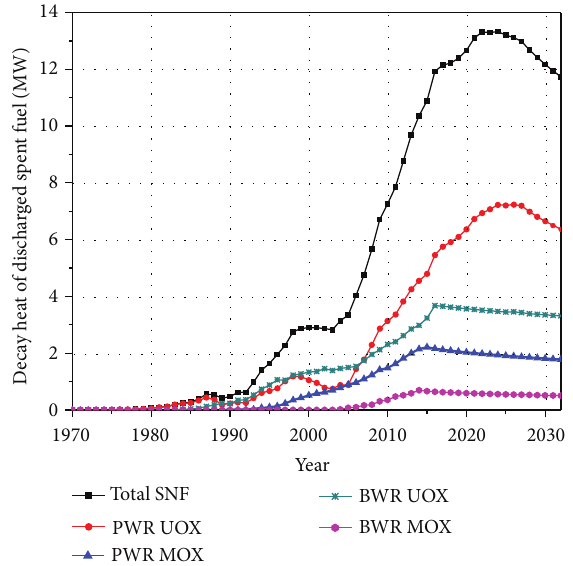
F 6: Decay power of accumulated spent nuclear fuel at date